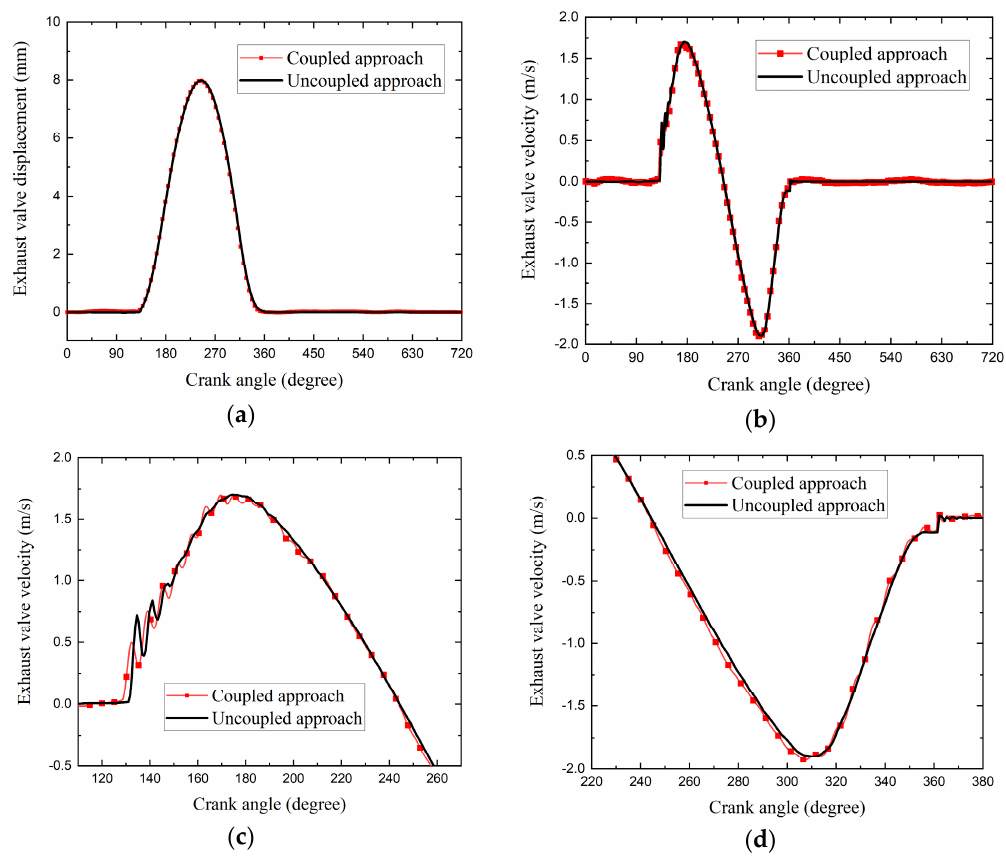
Figure 20. The exhaust valve displacement and velocity comparisons between the two approaches: ( a ) exhaust valve displacement; ( b ) exhaust valve velocity; ( c ) exhaust valve velocity (opening section); ( d ) exhaust valve velocity (closing section).